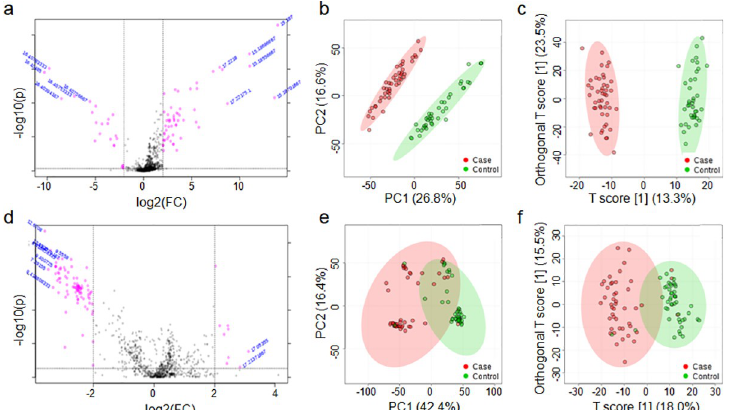
Fig 1. Discrimination analysis of AVS patients and control individuals through metabolomic profiling of biofluids. Metabolomic data were derived from GC-MS spectra of urine (a-c) and plasma (d-f) samples from AVS patients (n = 46) and healthy controls (n = 46). Univariate analysis of GC-MS spectral data in the 92 samples was performed to identify metabolomic features significantly separating cases and controls (nominal p < 0.05), which are plotted in pink dots in the upper part of the volcano plots (a, d). Multivariate statistics were applied to perform principle component analysis (PCA) (b, e) and orthogonal partial least squares-discriminant analysis (OPLS-DA) (c, f) and assess sample classification in cases and controls. The 95% confidence regions are displayed by shaded ellipses in AVS patients (red) and controls